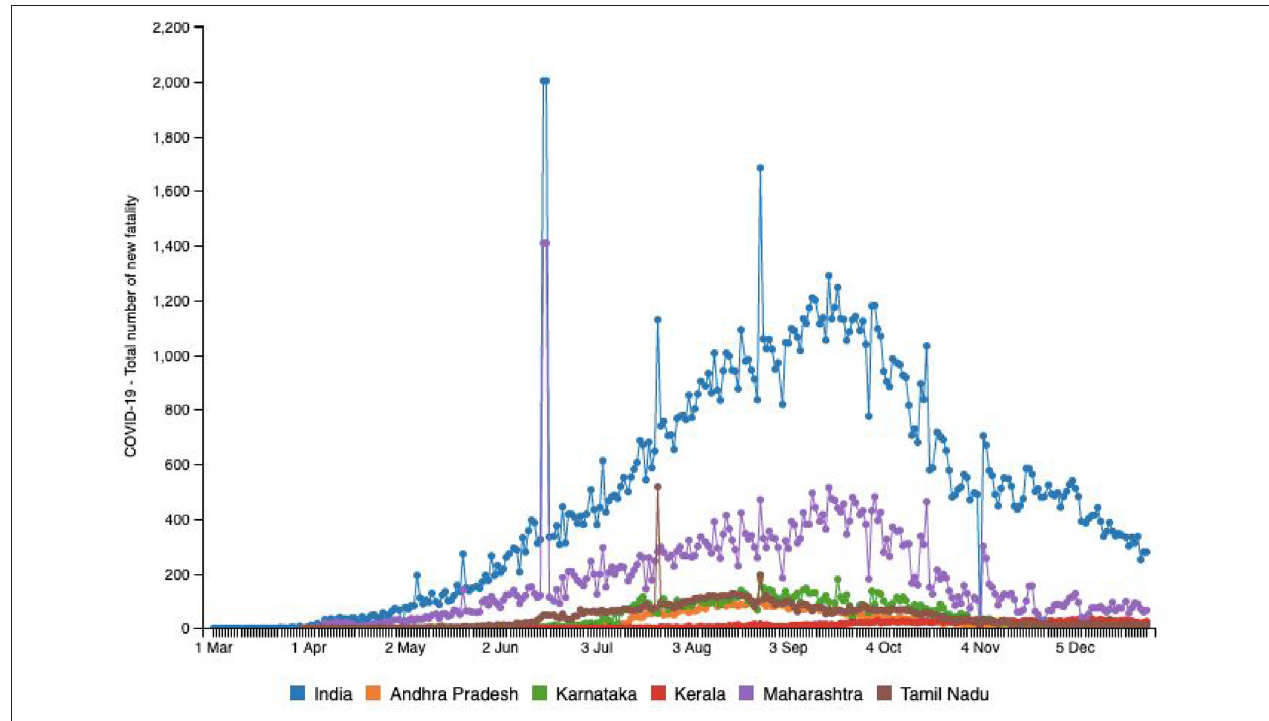
FIGURE 4 | Source: http://www.smaartrapidtracker.org, accessed on December 29, 2020. Status of COVID-19 Total number of new fatality in India, and in the states of Maharashtra, Andhra Pradesh, Delhi, Karnataka, Uttar Pradesh, and Tamil Nadu (March 1, 2020 to December 29,